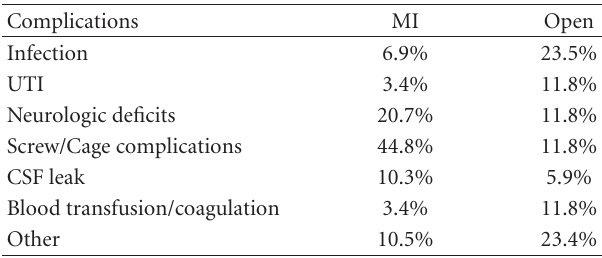
Table 4: Complication rate by TLIF